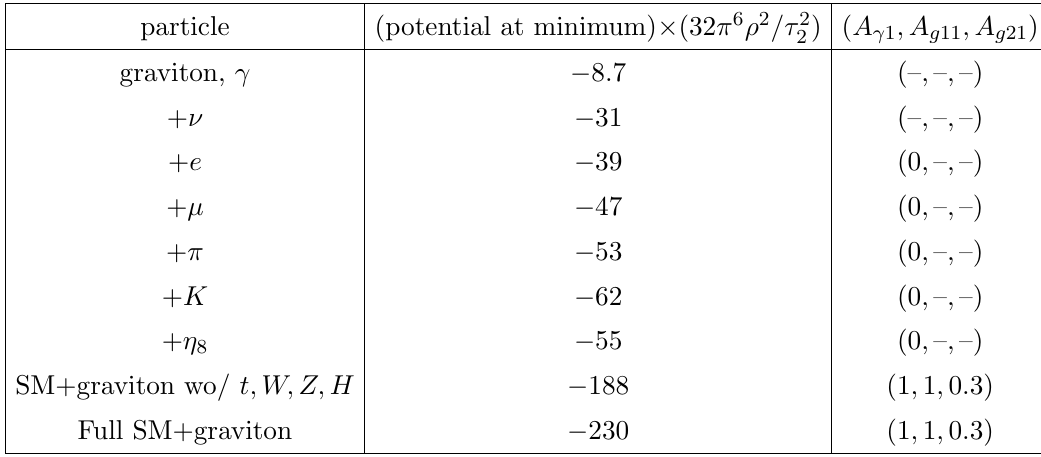
Table 8 . Same as (cid:12)gure 4, but for anti-periodic, Dirac neutrinos.